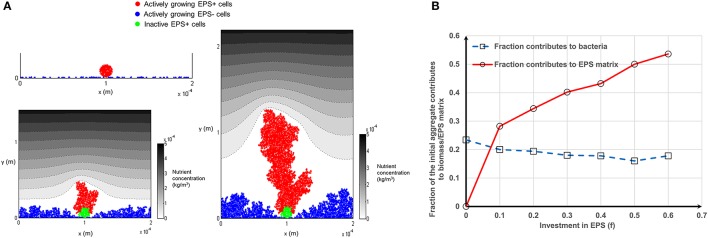
Inactive bacteria in the aggregate for Case 1: (A) As the biofilm grow some inactive bacteria are seen at the bottom of the aggregate. The inactive bacteria of the aggregate are shown in green color and these inactive bacteria would not contribute to biomass production (f = 0). Even though the aggregate gets a competitive advantage through its height the inactive cells in the bottom of the aggregate would be costly for it: (B) fraction of the active bacteria in the initially aggregated EPS+ strain as a function of investment in EPS production. As the investment in EPS increases from 0 to 0.6 the fraction contributes to bacteria production remains fairly constant around 0.2 and the fraction contributes to EPS production increases to around 0.55. Mass of the bacteria is the sum of the mass of EPS+ and EPS− strains. All values are in SI units.